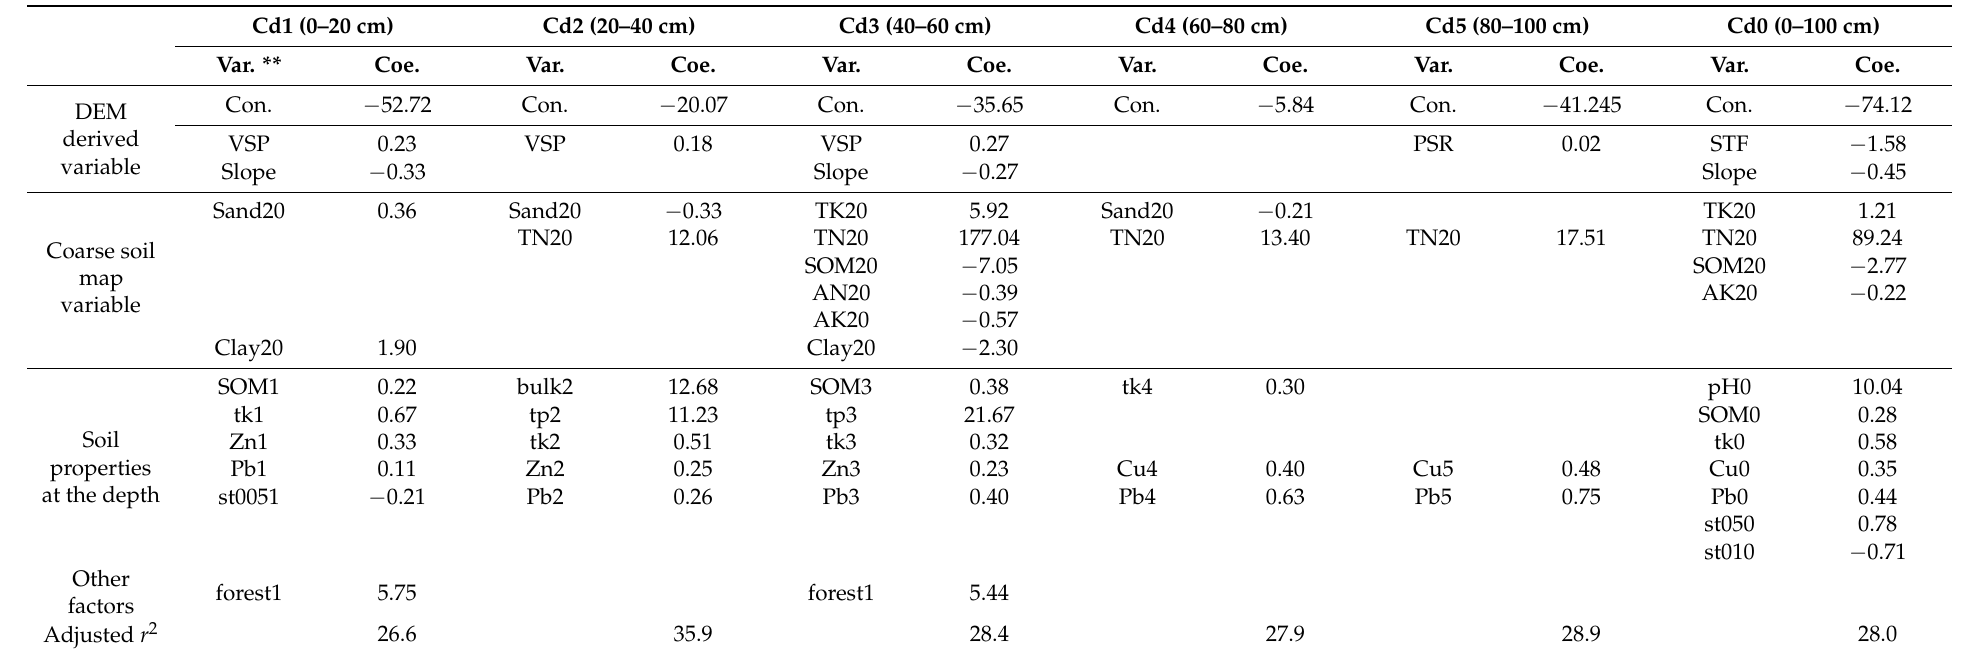
Table 5. Coefficients for predicting soil Cd concentration at different depths with stepwise regression models